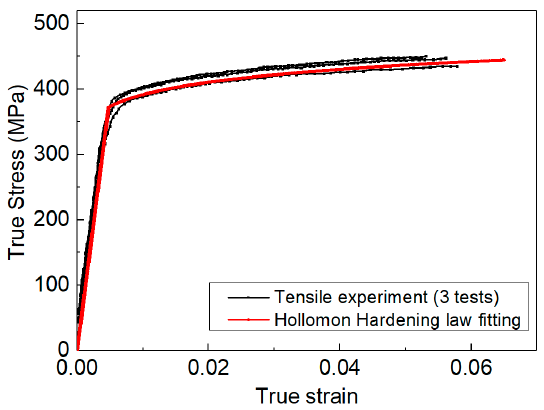
Figure 1. The stress–strain curves obtained from the tensile experiment. Table 1. Uniaxial mechanical properties obtained from the tensile